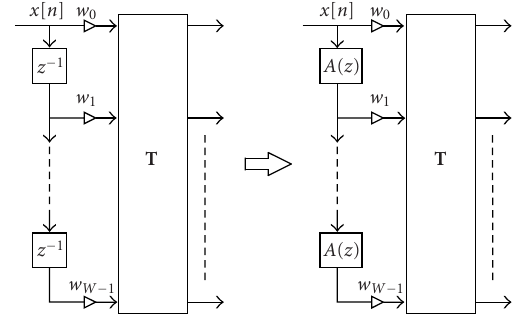
Figure 11: Modification of a nondecimated transform filterbank to obtain a frequency-warped